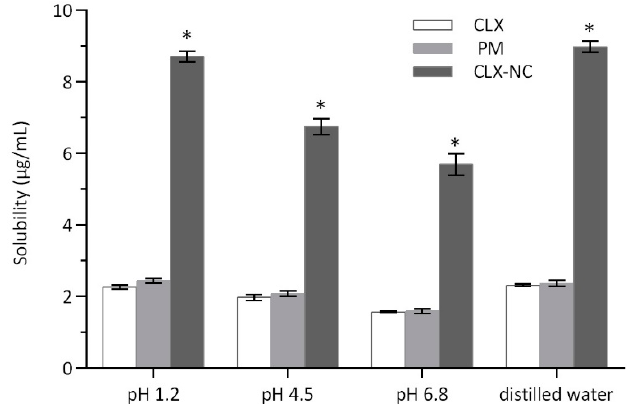
Figure 7. Apparent solubility of CLX crude powder, PM and optimized CLX-NC in different dissolution media (mean ± SD, n = 3). * implies significant at p ≤ 0.05 compared to CLX crude powder.